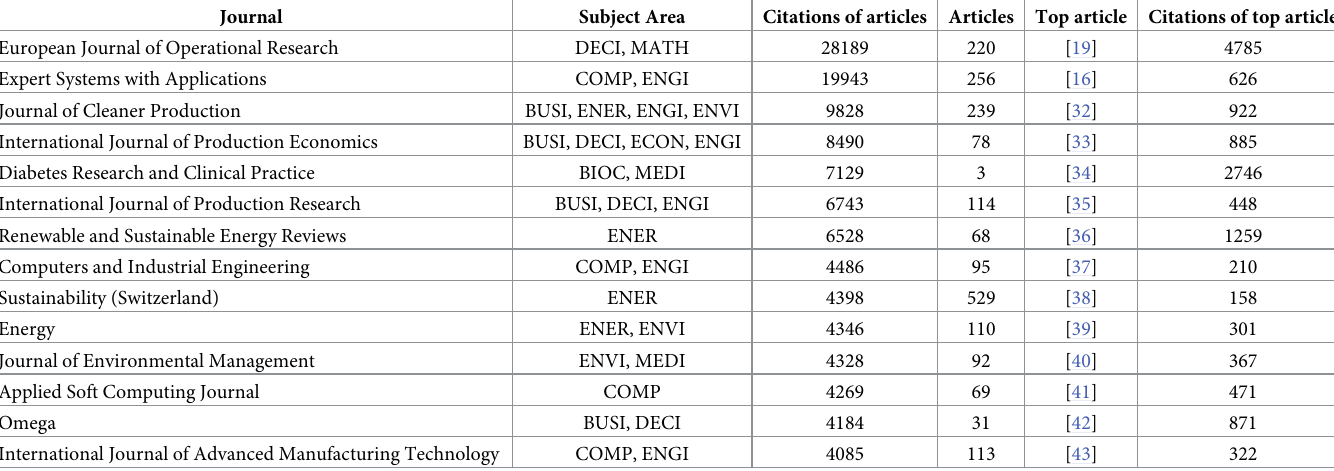
Table 1. Journals with the highest impact on AHP